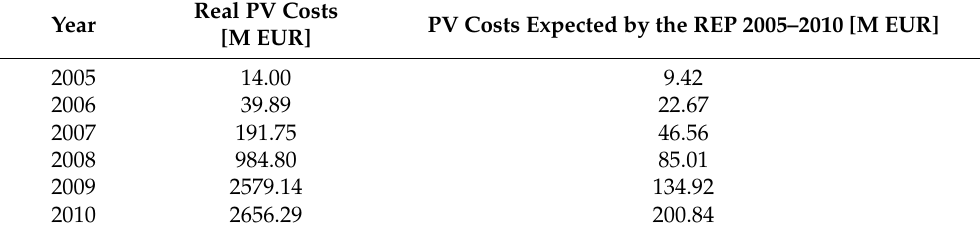
Table 12. Comparison between the real annual development costs of the Spanish solar PV sector and those expected by the REP 2005–2010 during the period 2005–2010. Source: self-elaboration based on